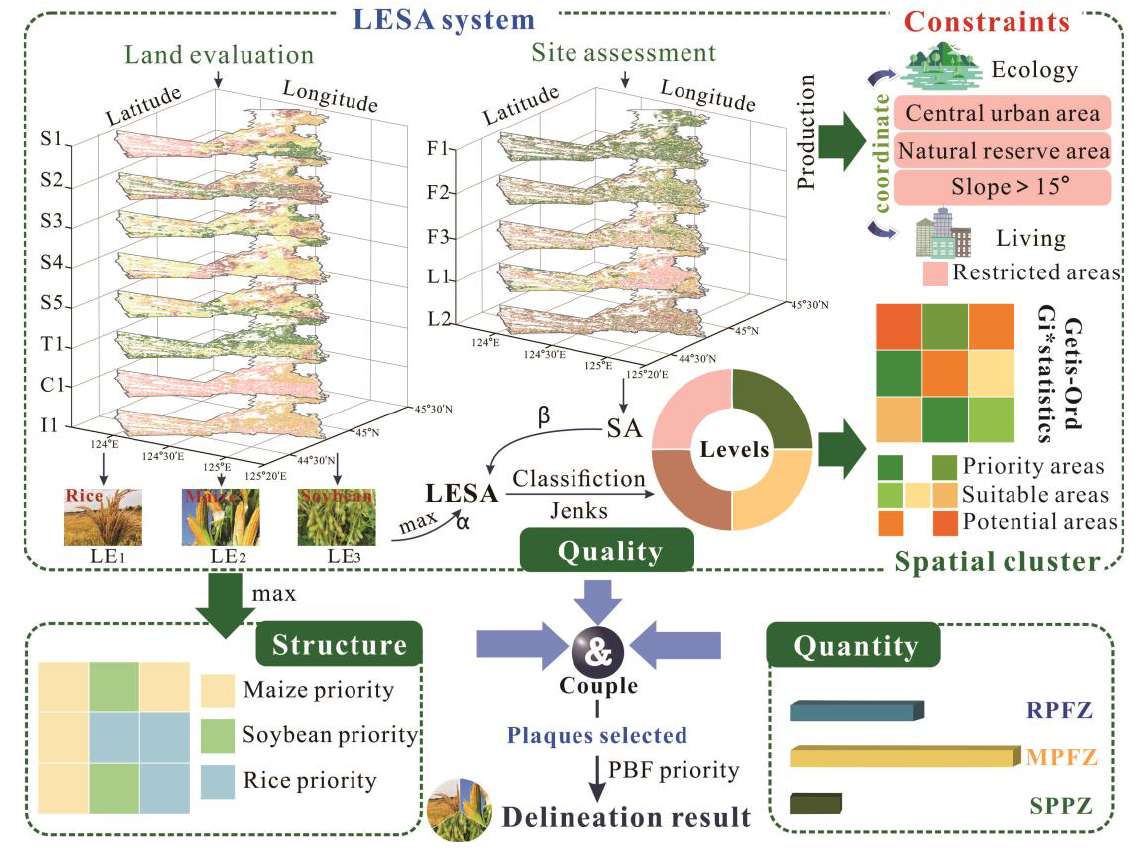
Figure 2. Overall technical framework of this study.